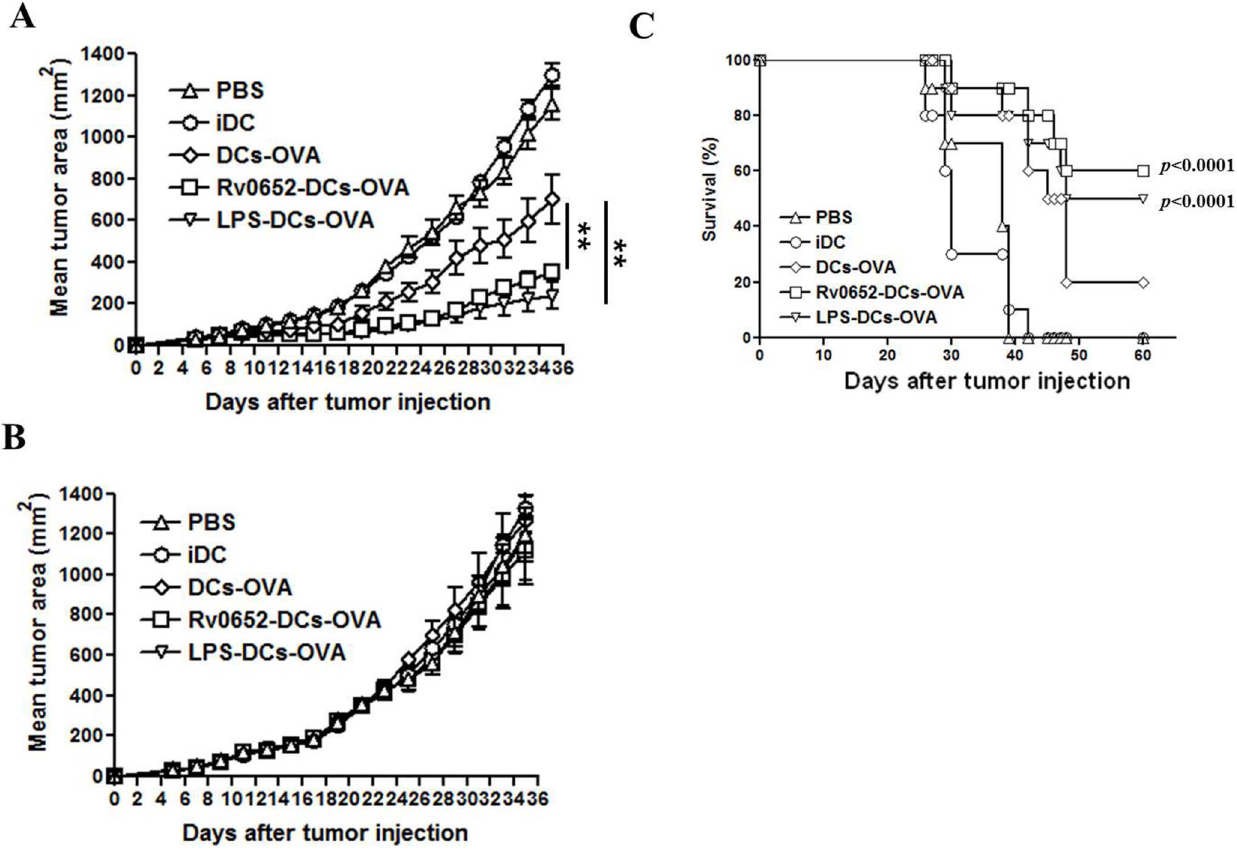
Figure 6. Rv0652-treated DCs pulsed with OVA 257–264 protects mice against E.G7 tumor challenge. C57BL/6 mice were challenged s.c with 3 6 10 5 E.G7 or EL4 tumor cells into the right flank area. For administration of DCs (1 6 10 6 cells/mice), mice were injected intravenously with PBS, iDC, DCs-OVA (DCs pulsed with OVA 257–264 ), Rv0652-DCs-OVA (Rv0652-treated DCs pulsed with OVA 257–264 ), or LPS-DCs-OVA (LPS-treated DCs pulsed with OVA 257–264 ) on days 1, 3 and 5 after the tumor challenge. Following the tumor challenge with E.G7 (A) and EL4 (B), tumor growth was monitored by measuring the diameter of the tumor every 2 days. ** P , 0.01, each group, n=10. (C) Survival of mice with an E.G7 tumor challenge after injection of OVA peptide-pulsed and Rv0652-treated DCs, n=10 mice/group. P value calculated by Kaplan-Meyer log-rank test between two groups of mice injected with DCs-OVA and Rv0652-DCs-OVA,